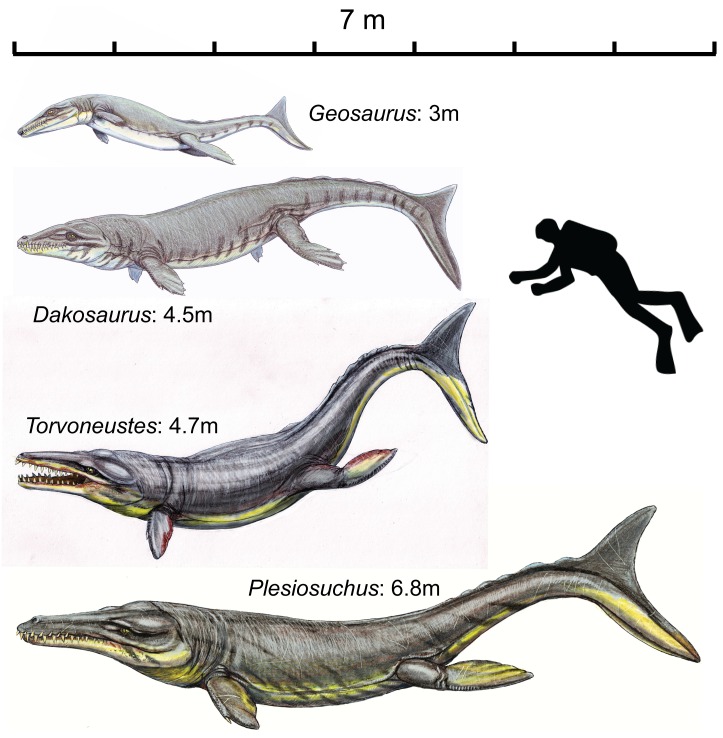
Life reconstructions showing the maximum body lengths for the four Geosaurini genera present in the late Kimmeridgian-early Tithonian of Western Europe.The species from top to bottom are: Geosaurus giganteus, Dakosaurus maximus, Torvoneustes carpenteri and Plesiosuchus manselii. The maximum known body lengths of Torvoneustes and Geosaurus are from Young et al. [14], while those of Dakosaurus and Plesiosuchus are from this paper. The human diver is 1.8 m in height. All metriorhynchid life reconstructions are by Dmitry Bogdanov.